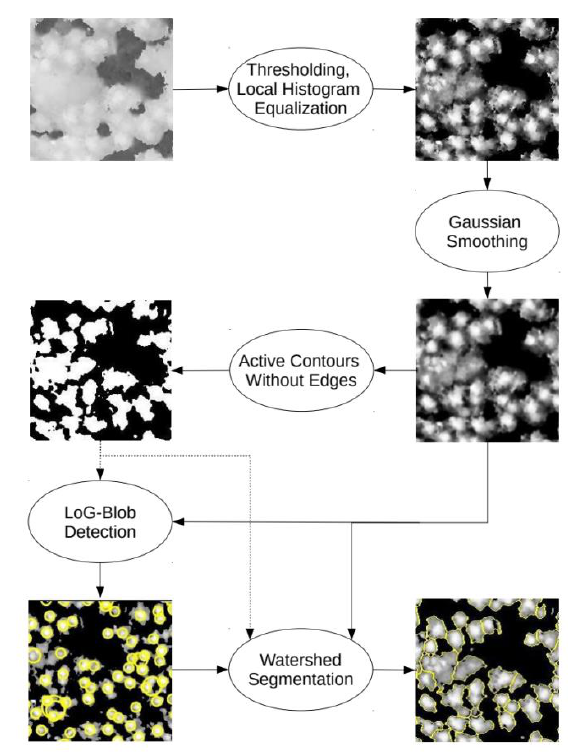
Figure 8. Workflow of the DSM-based ITC segmentation (Dashed lines denote an input for masking other inputs).